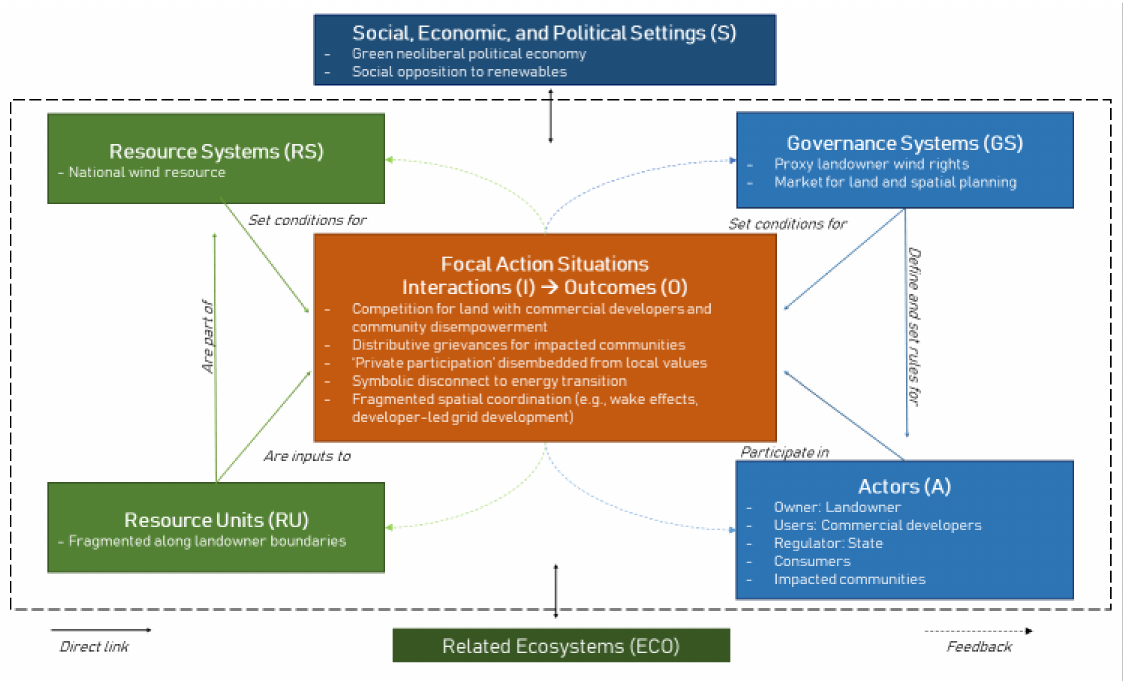
Figure 3. Scenario 1: Social-ecological model for wind energy under proxy landowner wind rights. Source: authors, based on Ostrom’s SES